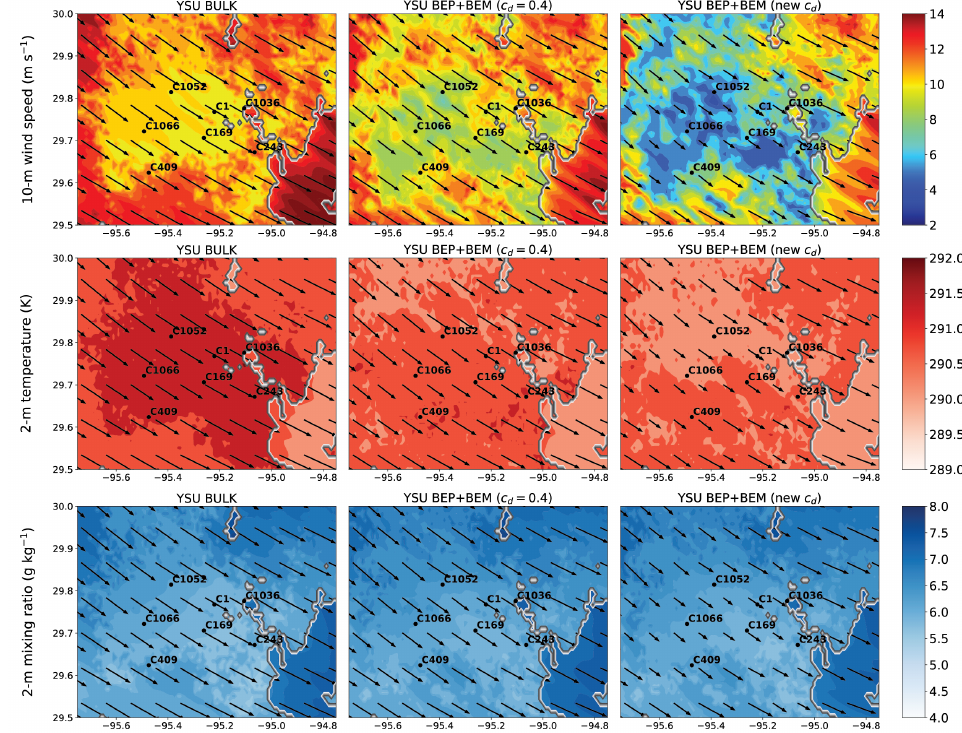
Figure 5. WRF model’s simulated near-surface fields at 6:00 p.m. UTC 22 January (1:00 p.m. LST). Vectors are shown every 10 model grid